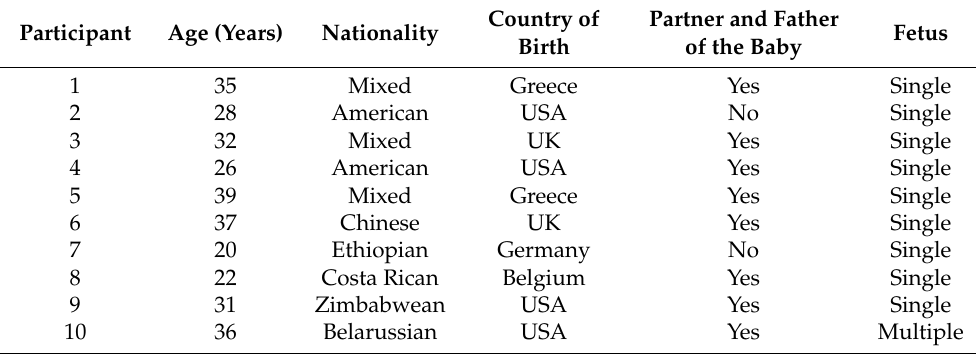
Table 1. Overview of the ten interviewed